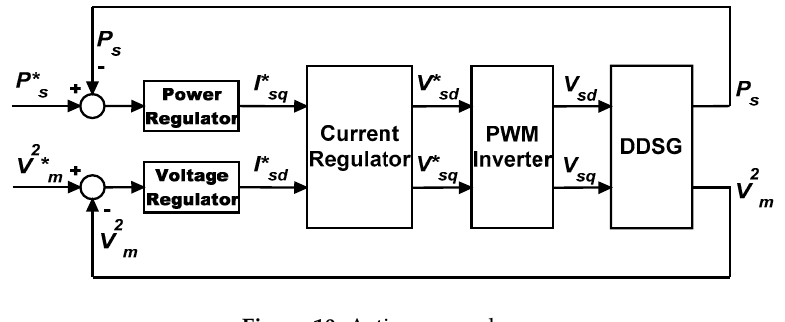
Figure 10. Active power loop.